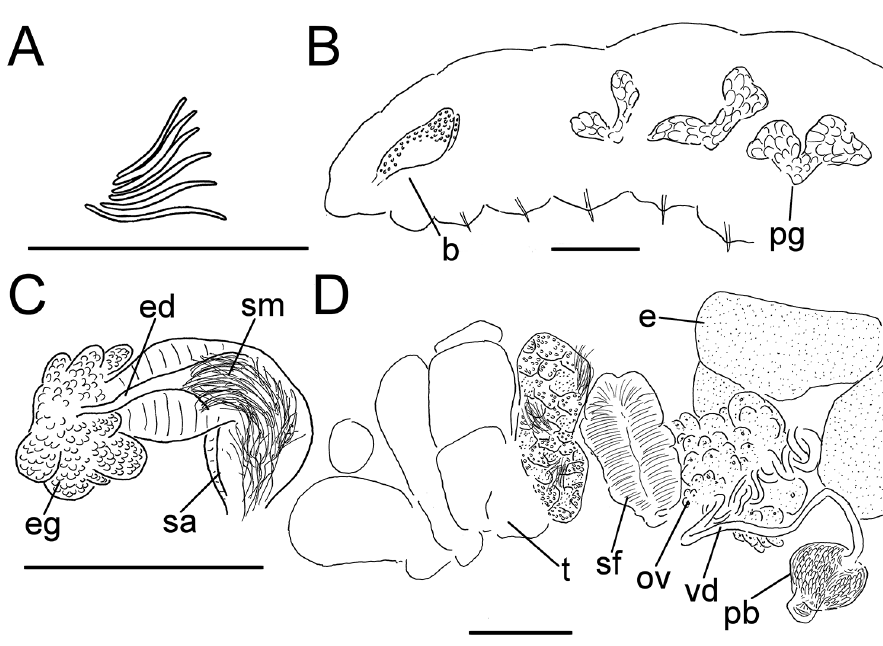
Figure 11. Lumbricillus pumilio . A Chaetal bundle B Anterior body C Spermatheca D Other genitalia. Abbreviations under general notes. Scale bars: 100